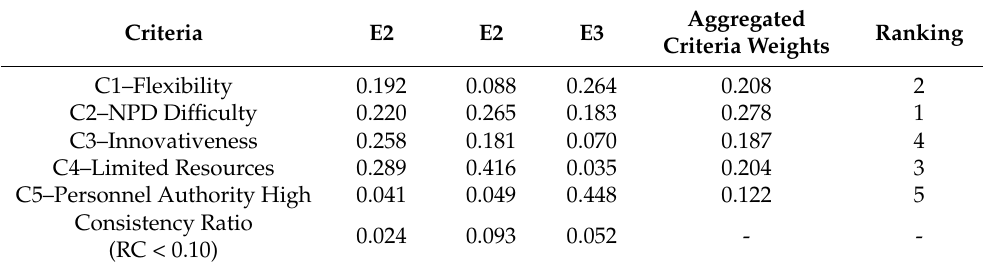
Table 6. Criteria weights (AHP method) from Brazilian experts (Ei).